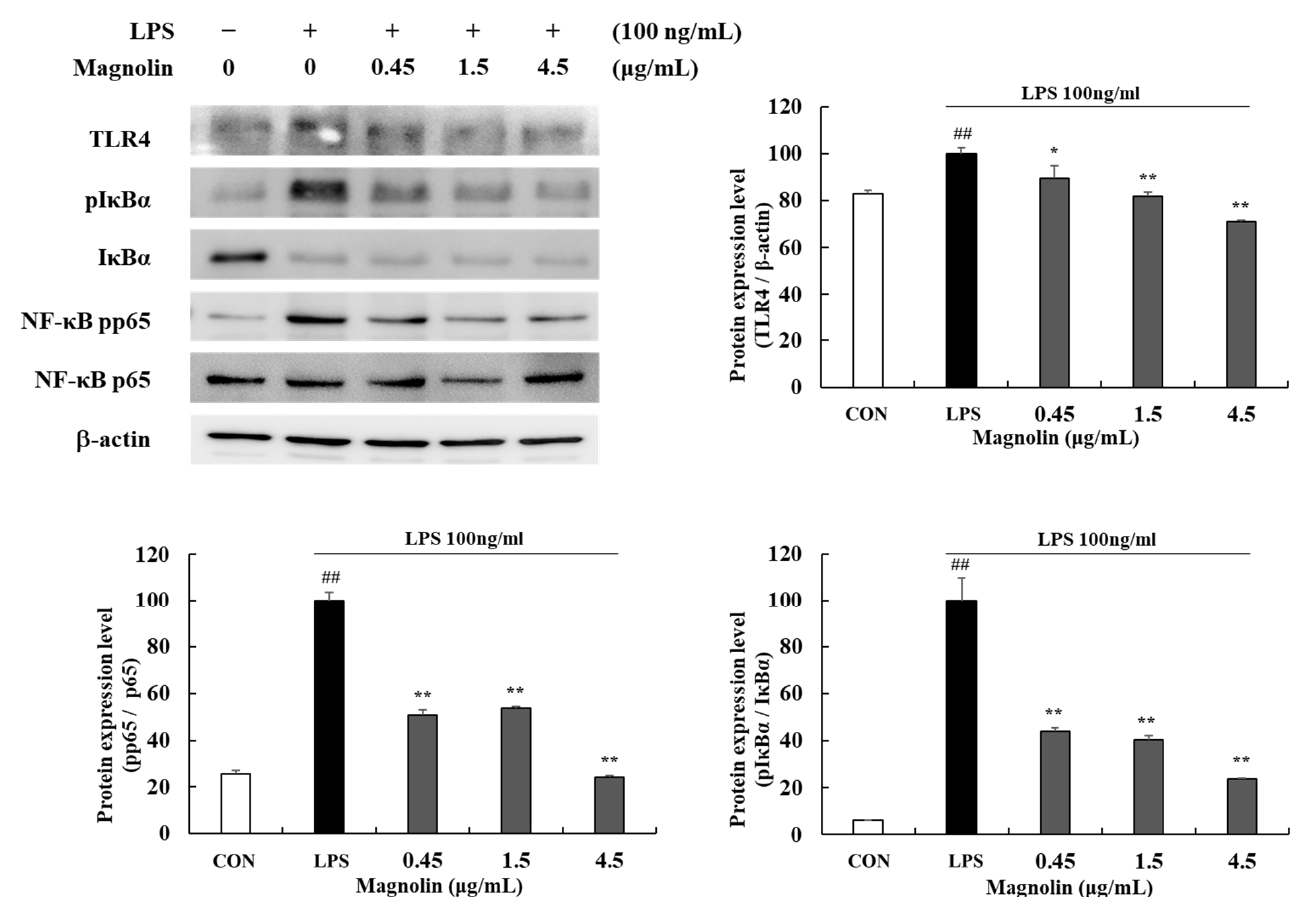
Figure 9. Effects of magnolin (0.45, 1.5, and 4.5 μg/mL) on the production of TLR4 and NF-κB factors in LPS-stimulated RAW 264.7 cells. Magnolin and 100 ng/mL of LPS was added except for in the vehicle control group and incubated at 37 °C for 15 min. Protein expression levels of TLR4, pIκBα, IκBα, pp65 and p65 were detected by Western blot. The protein band density was measured by utilizing ImageJ software. β-actin was used as a control for TLR4 protein expression level. Values represent means ± standard deviation. ## p < 0.01 vs. Vehicle control group; * p < 0.05 and ** p < 0.01 vs. LPS-activated control group.